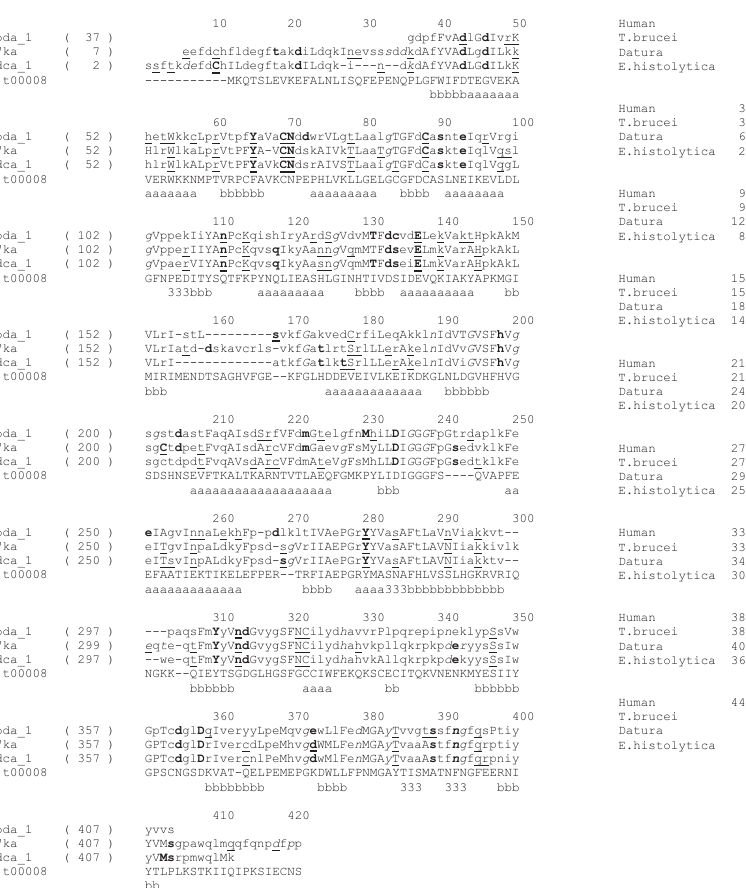
ODC gene, GenBank [http://www.ncbi.nlm.nih.gov/Genbank/] accession number AY929249).